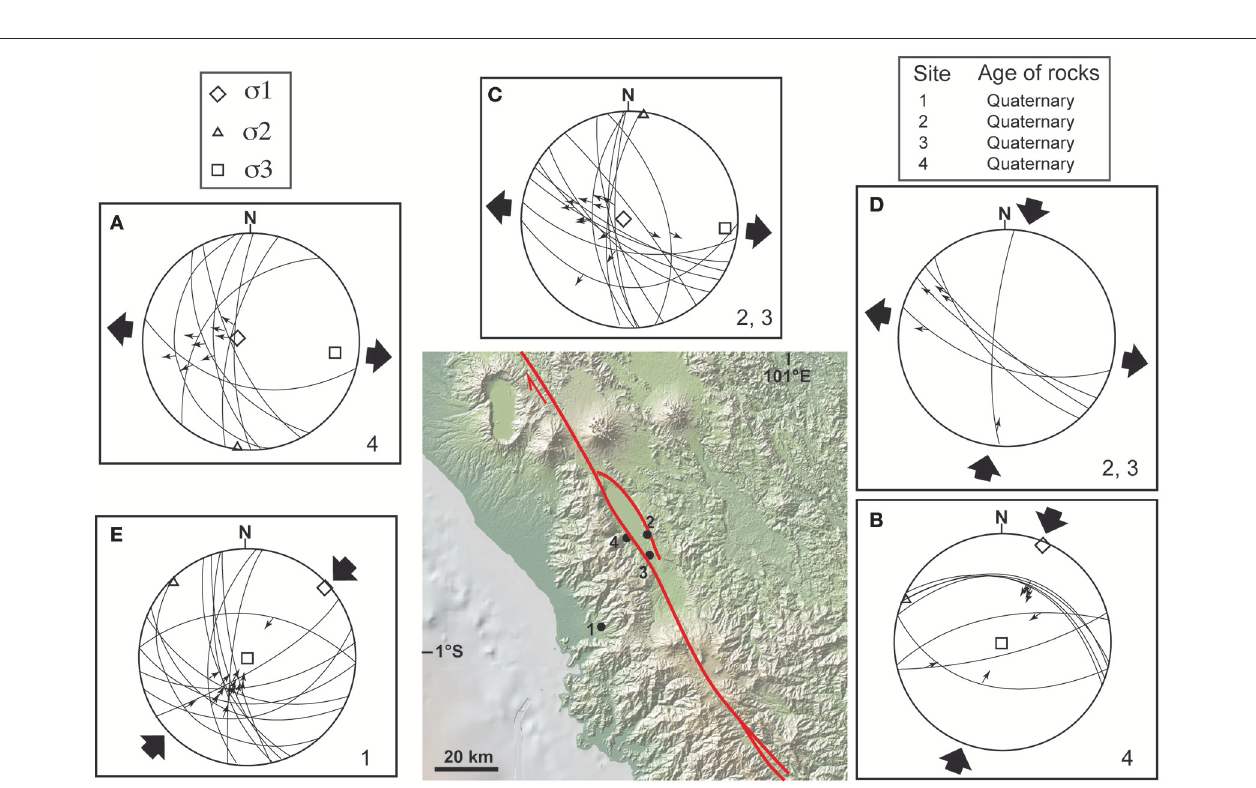
a NNW-SSE strike ( Figure 11C ), and are associated to